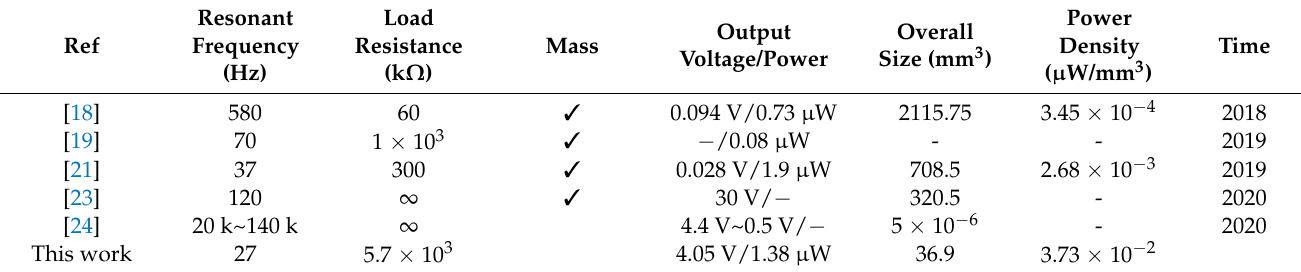
Table 2. Comparison of recent doubly clamped energy harvesters’ main